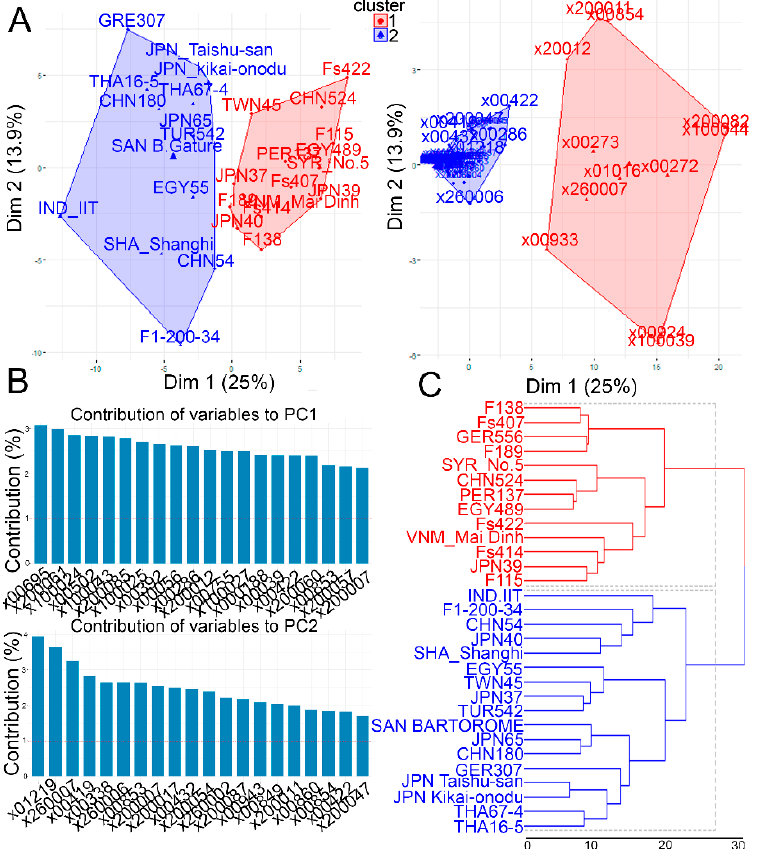
Figure 2. Principal component analysis (PCA) and dendrogram clustering of the normalized metabolite intensities in 30 garlic accessions: ( A ) PCA loading and score plots of PC1 and PC2, ( B ) top metabolite contribution percentages to PC1 and PC2, and ( C ) the dendrogram cluster.